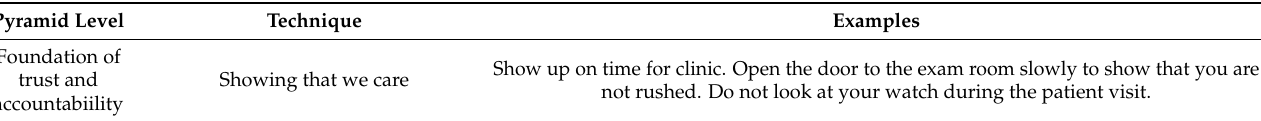
Table 1. Patient adherence techniques and examples for the cutaneous T-cell lymphoma